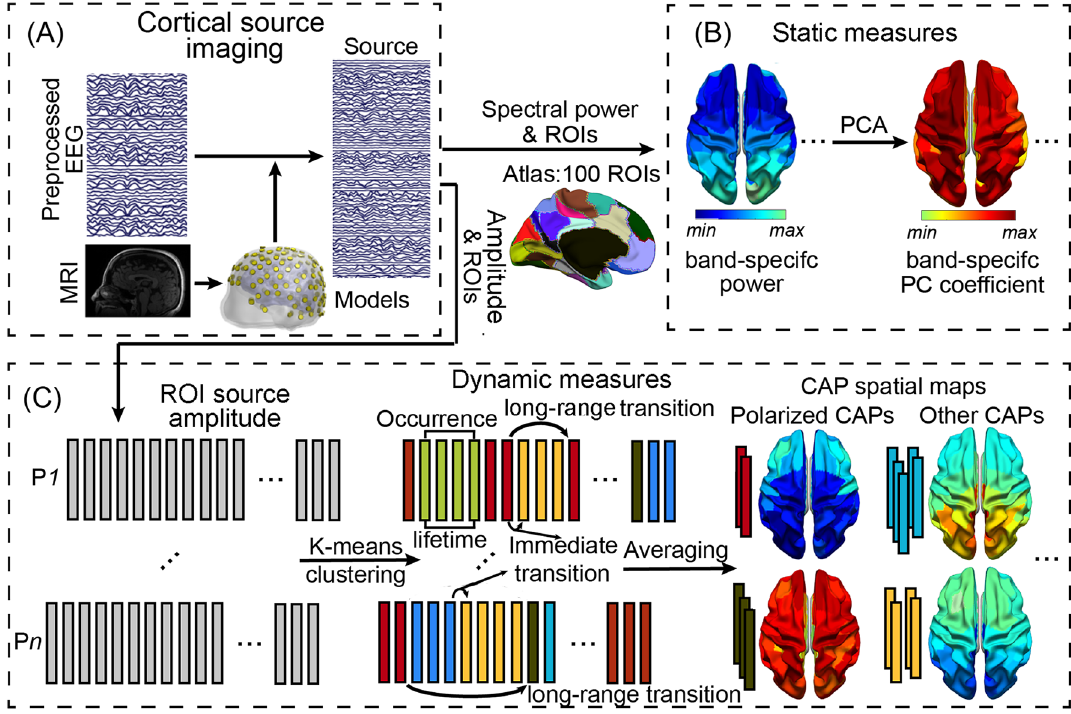
Figure 1. Schematic illustration of the method. ( A ) Cortical source imaging in reconstructing cortical sources from preprocessed EEG signals using individual volume conduction models from MRI; ( B ) Static measures of band-specific powers over 100 ROIs based on an atlas for the whole cortex and PCA-based whole-brain band- specific powers; ( C ) Dynamic measures defined on CAPs (identified via a k-means clustering on source envelop data at the resolution of single timeframes): the occurrence and lifetime of individual CAPs, temporal metrics involving immediate transitions from one CAP to another, and long-range transitions between two polarized CAPs (see “Methods”).